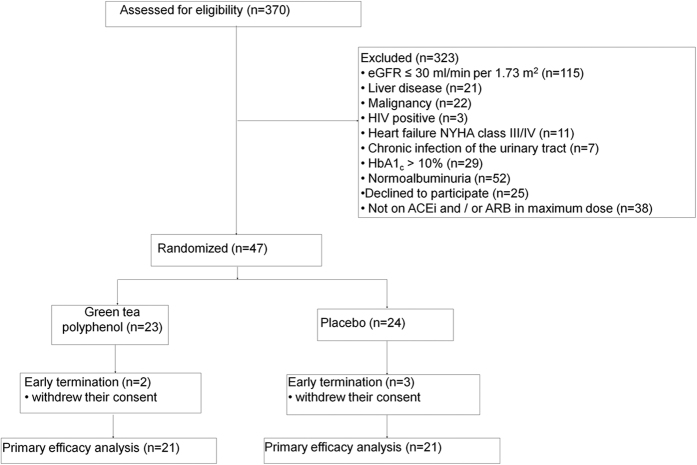
Flow diagram of the trial.eGFR, estimated glomerular filtration rate; HIV, human immunodeficiency virus; NYHA, New York Heart Association; HbA1c, glycated hemoglobin; ACEi, angiotensin-converting enzyme inhibitor; ARB, angiotensin receptor blocker.